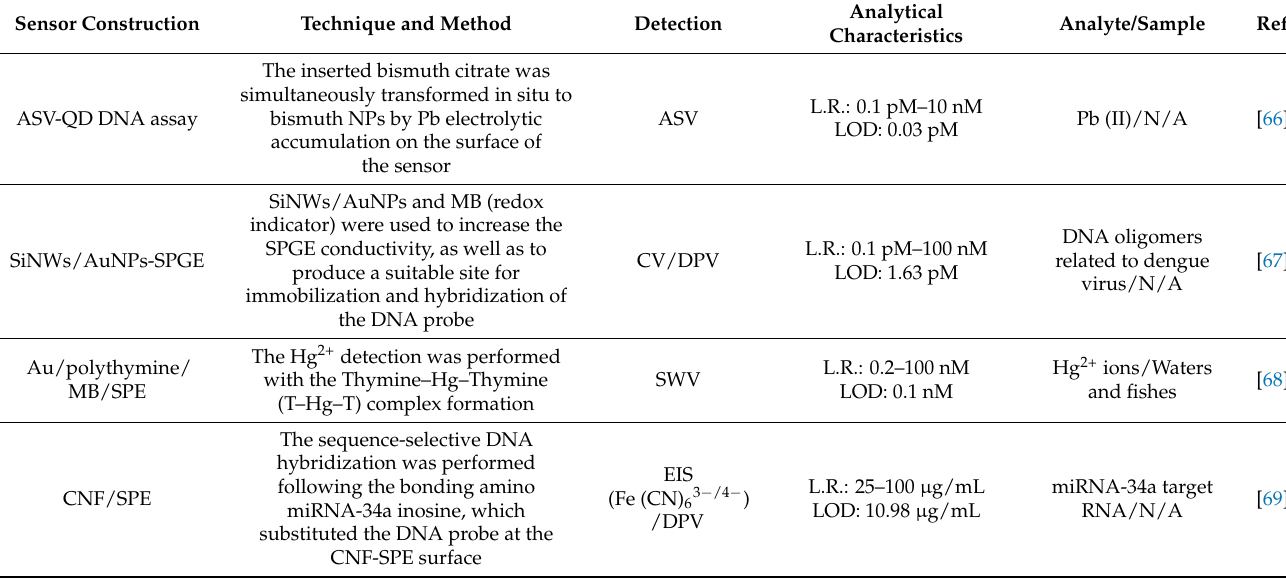
Table 1. DNA SPE biosensors for (bio)compound measurements in various